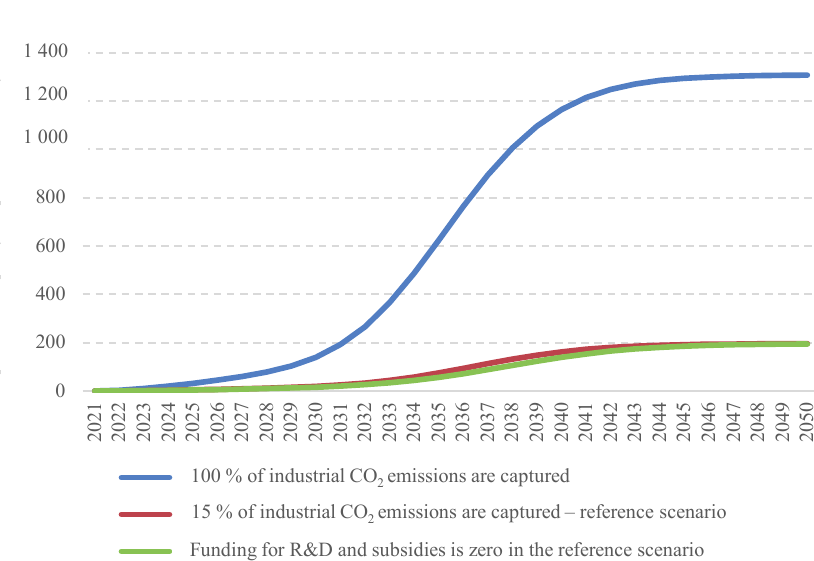
Fig. 5. Dynamics of the ethanol production capacity in operation depending on the fraction of industrial (including energy production) CO 2 emissions that are captured as well as funding for R&D and subsidies.